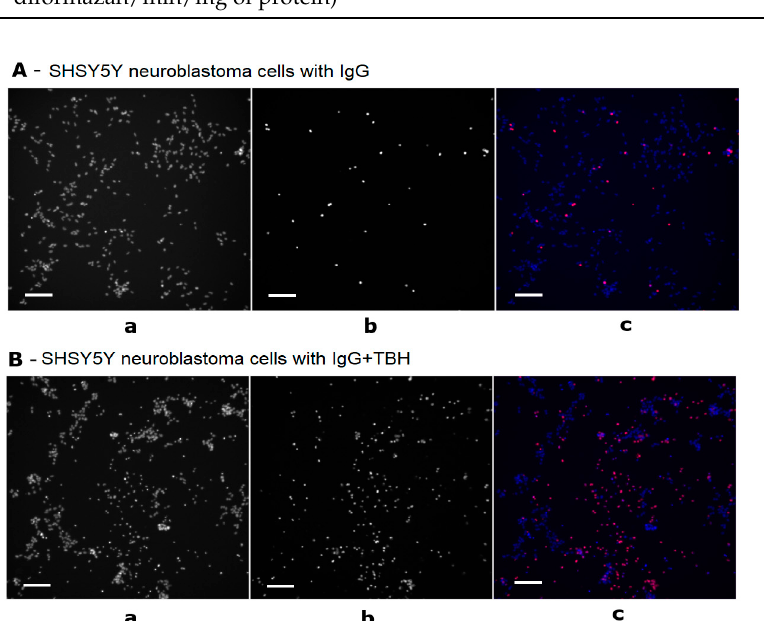
Figure 3. Registration of cells on the CX7 platform. ( A ): SH-SY5Y cells after 24 h of incubation with IgG from schizophrenic patients; ( B ): SH-SY5Y cells after 24 h of incubation under conditions of induced oxidative stress (TBH) along with IgG from schizophrenic patients. ( a ) Cells stained with the Hoechst fluorescent dye; ( b ) cells stained with fluorescent dye propidium iodide; ( c ) cells stained with Hoechst + propidium iodide. Scale bars: 100 µ